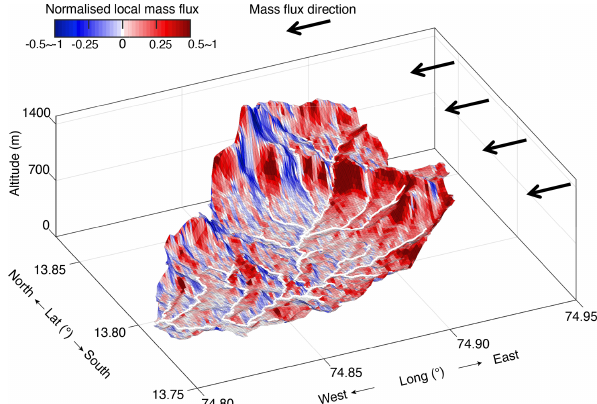
Figure 8. Local mass flux of elemental surfaces of an escarpment- draining basin in the Western Ghats. Basin location is indicated as basin D in Fig. 2 and is also shown in Fig. 6. The basin surface is discretized into elemental surfaces and color-coded with the relative magnitude of the local mass flux for a horizontal rock velocity in the direction indicated. Flux is normalized to the catchment-averaged mass flux. Thick white lines are channels extracted from the DEM for a minimum drainage area of 1km 2